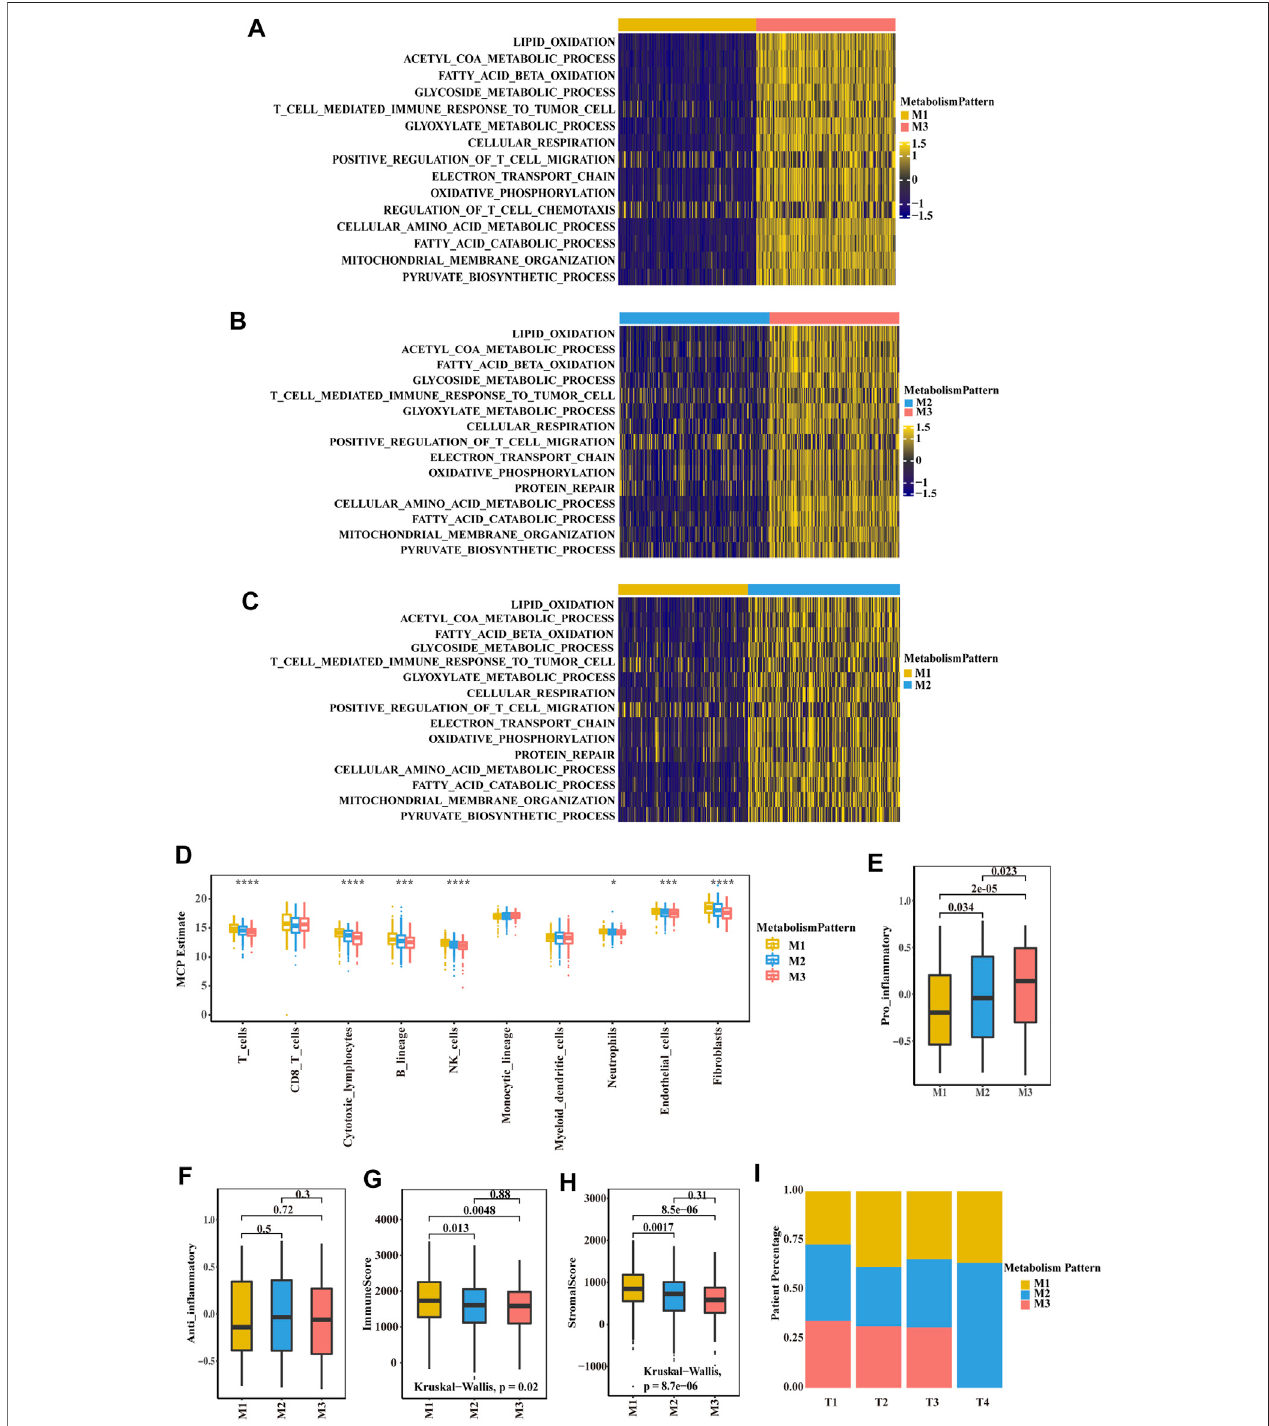
FIGURE2 | Biological characteristics ofthree metabolism-associated patterns in the TCGA-KIRC cohort. (A – C) GSVA enrichment analysis showing the activation statesofbiologicalpathwaysindistinctmetabolicpatterns.Aheatmapwasusedtovisualizethesebiologicalprocesses.Yellowrepresentsactivatedpathways,andblue represents inhibited pathways. (A) M1 vs. M3 (B) M2 vs. M3 (C) M1 vs. M2. (D) Boxplot of the abundance of immune and stromal cell populations distinguished by differentsubclasses.Theasterisksrepresentastatisticallysigni fi cant p value(* p < 0.05;** p < 0.01;*** p < 0.001;**** p < 0.0001).( E – F) Boxplotofpro-in fl ammatory macrophage (E) and anti-in fl ammatory macrophage (F) to compare thedifference ofthree subclasses. p values were determined by astudent ’ s t test. (G-H) Boxplot of immunescore (G) andstromalscore (H) fromESTIMATEofthreesubclasses.TheKruskal – Wallistestwasusedtocomparethesigni fi cantdifferencesbetweenthethree subclasses. (I) The proportion of the three metabolic patterns in the different T stages (T), T1, T2, T3 and T4.